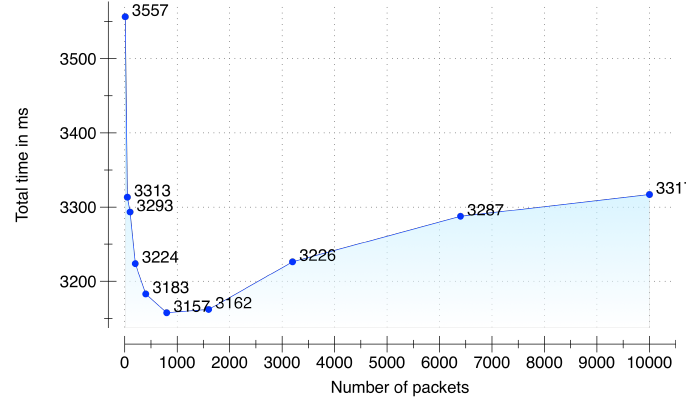
Figure 8. Performance testing.